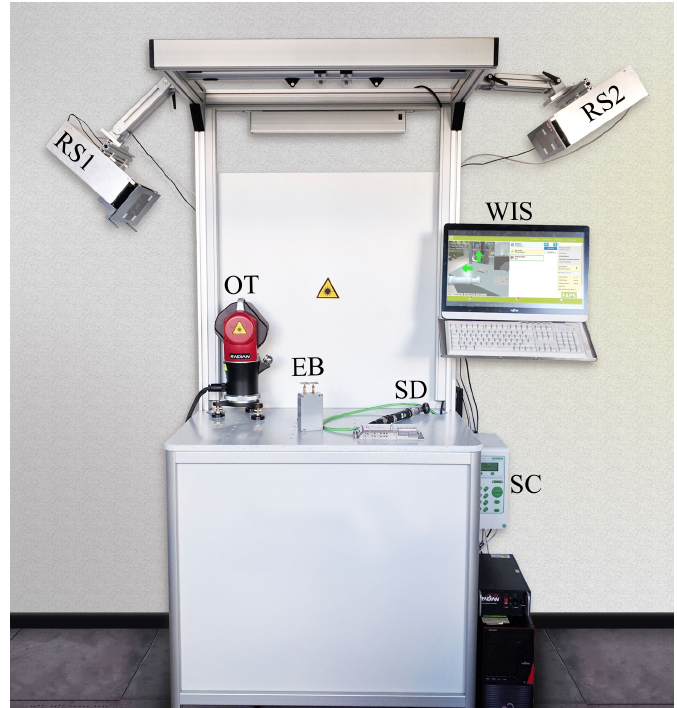
Figure 1. Experimental workstation setup with a worker information system (WIS), an optical tracker (OT) as a reference, a localization system consisting of two 24 GHz remote stations (RS1, RS2), and one mobile experimental beacon (EB), screwdriver (SD), and screwdriver control unit